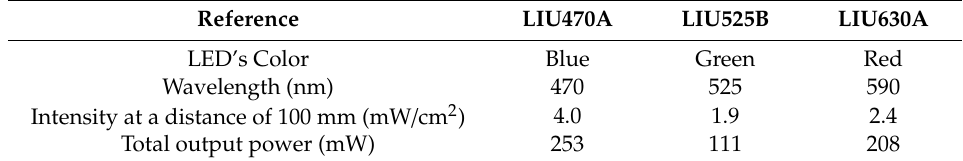
Figure 2. Experimental setup for photo-capacitor characterization of the polymer composite. Table 1. Properties of Thorlabs’ LED array light sources [5], including 3 di ff erent colors Blue, Green, and Red, that was specified by the